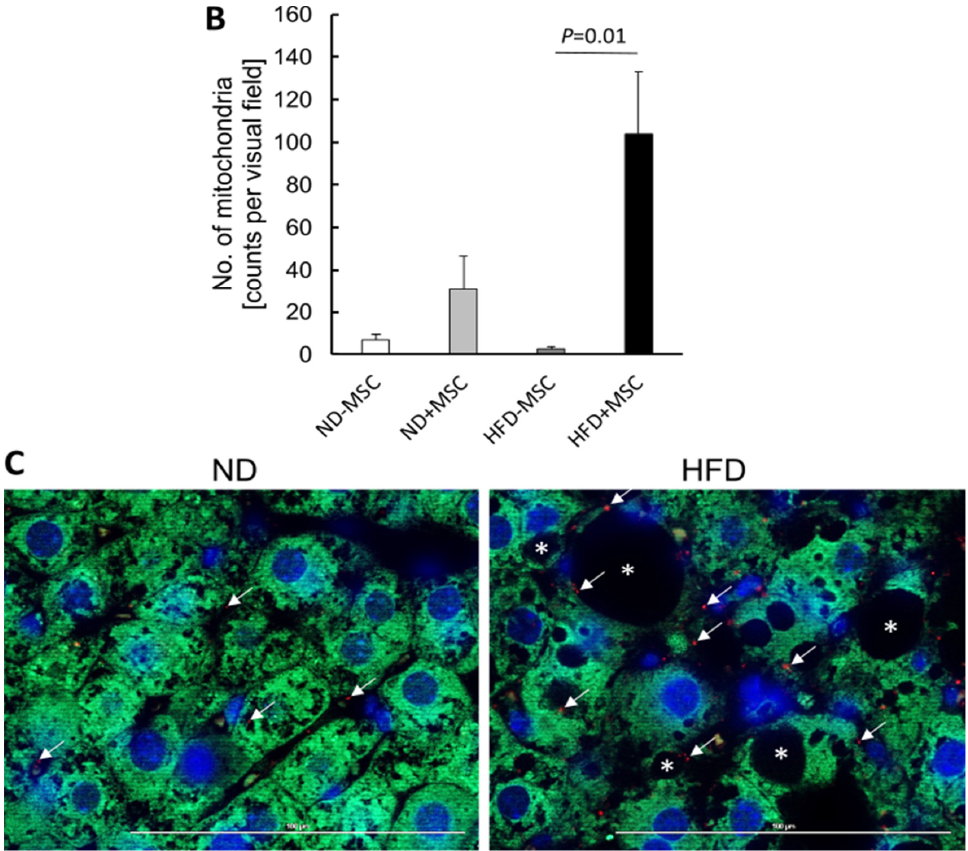
Figure 8. Human mitochondria derived from transplanted hBM-MSC in mouse hepatocytes. Mice fed the control (ND) or the high fat diet (HFD) were either treated (+MSC) or not ( − MSC) with human bone-marrow-derived MSC. ( A ) Mouse cyclophilin (green in left column (overlay); white/grey in right column (green channel)) and human mitochondria (red in left column (overlay); white/grey in middle column (red channel)) were detected by immunofluorescence on liver tissue slices using species-specific antibodies. Images were taken with the Zeiss Axio Observer.Z1 microscope with ApoTome.2 at a 40× objective magnification. White arrows mark human mitochondria in livers receiving human MSC. Livers without MSC transplants did not display signals. Nuclei were stained with DAPI (blue). Asterisks label lipid droplets in livers of animals fed the high fat diet. Pictures are representative for livers from 2–3 animals in each group. ( B ) Quantitative image analysis of pictures shown representatively in ( A ). Values are mean counts ± SEM from 5 visual fields each on slices from 2 different animals in the (ND − MSC), (ND + MSC), (HFD − MSC) and from 7–8 visual fields each on slices from 3 different animals in the (HFD + MSC) group, respectively. Visual fields were analyzed using the Image J software as described under Materials and Methods. Statistics were calculated with SPSS 23. After evaluation of standard distribution, the Kruskal–Wallis algorithm and post hoc Bonferroni were applied for calculation of significance. ( C ) Representative images displaying the co-localization of mouse cyclophilin (green) and human mitochondria (red) in hepatocytes of mice receiving MSC transplants either fed the control diet (ND) or the high fat diet (HFD). Procedures were as described in ( A ) except that images were taken at the 63× objective magnification. Scale bars—100 µm.